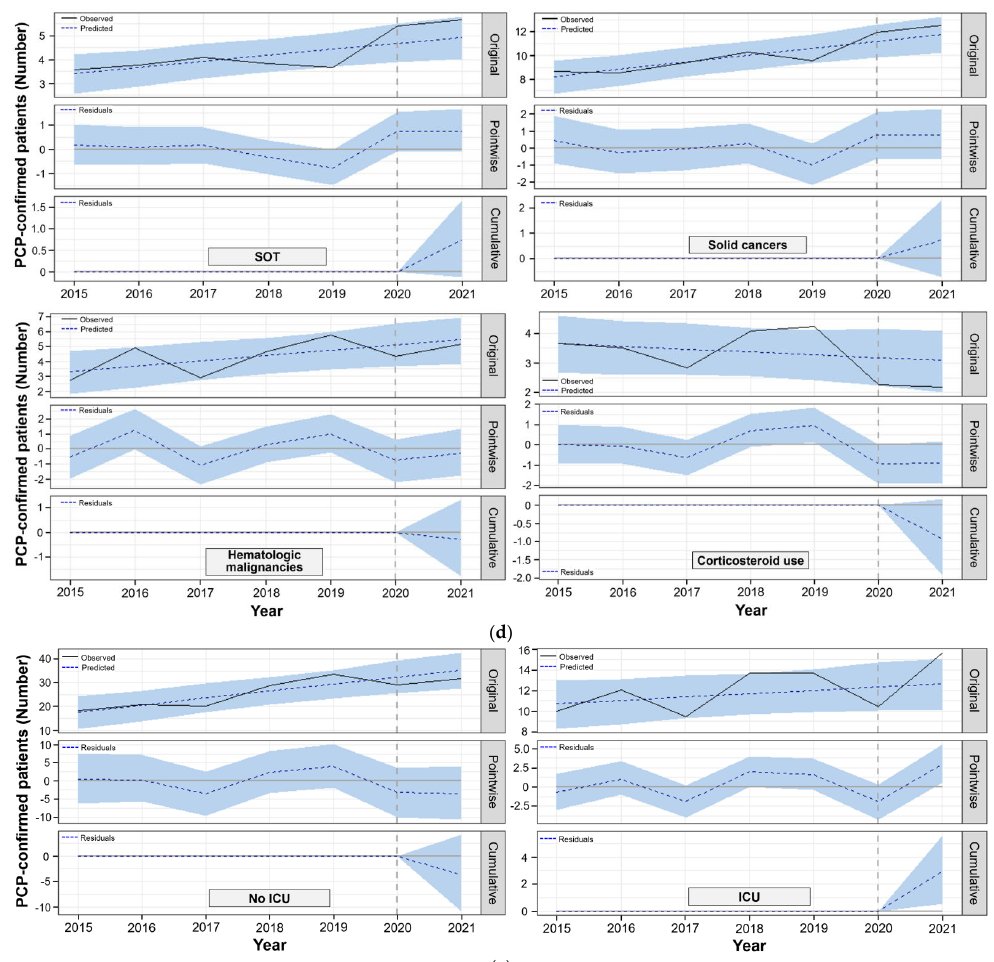
Figure 2. Channing pattern of the observed and predicted PCP-confirmed inpatients in the pre- and post-COVID-19 periods by the Bayesian structural time-series model. ( a ) All PCP-confirmed inpatients; ( b ) age; ( c ) sex; ( d ) immunocompromised conditions; ( e ) ICU care. The number of PCP-confirmed patients (Y-axis) indicated the average of observed PCP cases per month in each year. Gray dotted vertical lines (January 2020) indicate that the intervention of enforced NPIs arose from the COVID-19 pandemic in this study. The sky blue zone indicates the values between the upper and lower 95% CIs. Abbreviations: CI, credible interval; ICU, intensive care unit; ImmC, immunocompromised conditions; NPI, non- pharmacological intervention; PCP, P. jirovecii pneumonia; SOT, solid organ transplantation. As our time-series data showed stationary characteristics without seasonality, which means that the mean, variance, and covariance of data were invariant to time, in the aug- mented Dickey–Fuller test ( p < 0.001) [66], we applied the non-seasonal ARIMA (1, 0, 1) model using the following parameters, with the lowest Akaike Information Criterion value (388.7): (1) 1 of autoregression (p) from the autocorrelation function of residuals, (2) 0 of degree of differencing (integrated, d), and (3) 1 of size of the moving average window